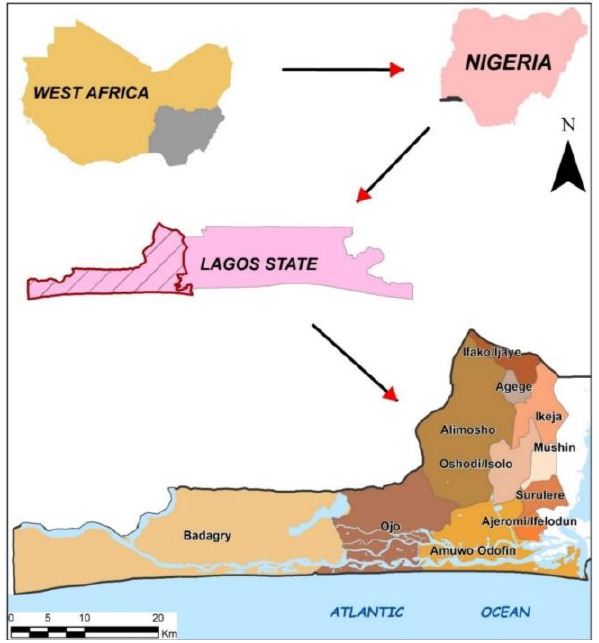
Fig. 1. Map of the study